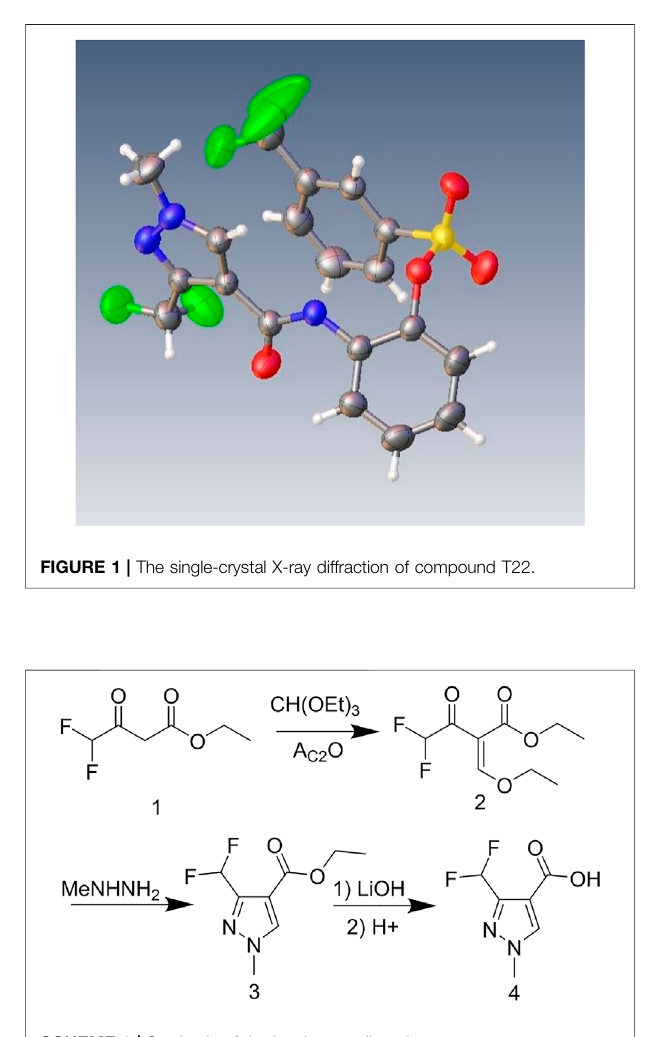
SCHEME 1 | Synthesis of the key intermediate 4 .